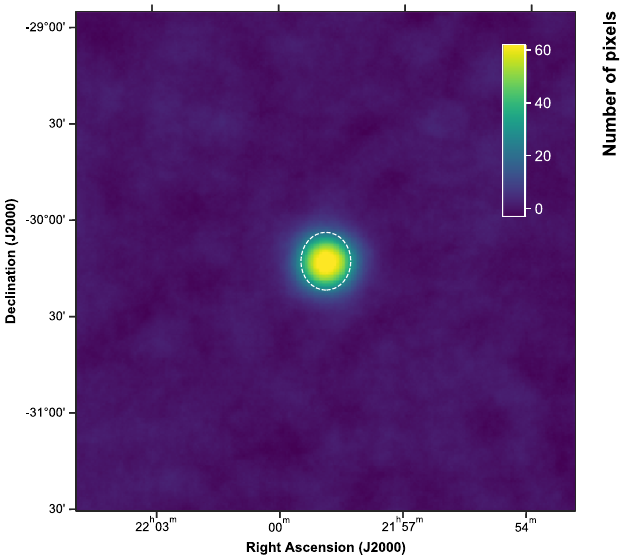
Fig. 7 Left: Significance map of the PKS 2155-304 region created using an oversampling radius of 0.12 ◦ at 80% gamma-ray efficiency, the position of the source is marked with the dotted circle. Right: 1D